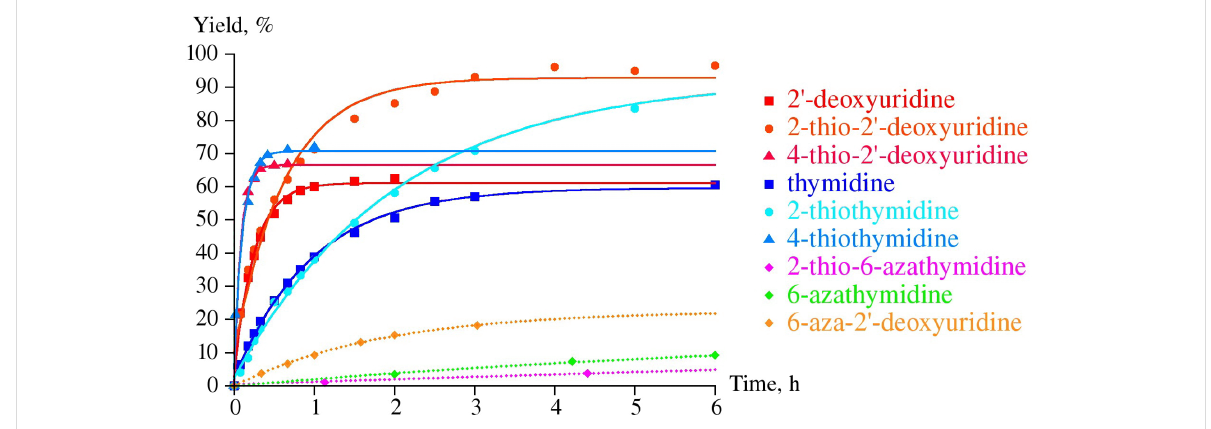
Figure 1: Phosphorolysis of a number of 2’-deoxy- β -D-ribofuranosides of uracil and thymine, and their 6-aza derivatives in comparison with the corre- sponding 4- and 2-thio derivatives catalyzed by E. coli UP. Reaction conditions: reaction mixture 1.0 mL; 25 m М K,Na-phosphate buffer ( рН 7.0), 20 °C; 2 m М testing nucleoside. Enzyme: 0.016 units of E. coli UP (substrates drawn with solids lines) or 1.9 units of E. coli UP (substrates drawn with dotted lines); reaction progress was monitored by HPLC (see Supporting Information File 1); yields refer to the percentage of the resulting hetero- cyclic base.